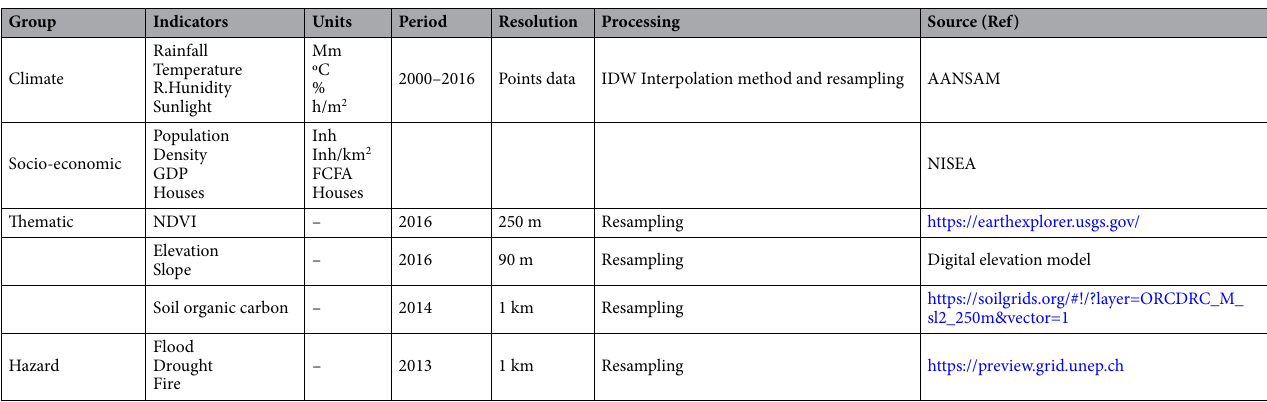
gross domestic product (GDP), and number of houses; thematic data such as the normalized difference vegeta- tion index (NDVI), soil organic carbon, digital elevation model (DEM) and slope; and environmental hazard data 3,34 such as flood, drought and bush fire frequency. Climate data were obtained from the Agency for Aerial Navigation Safety in Africa and Madagascar (AANSAM), socioeconomic data were provided by the National Institute for Statistics and Economic Analysis (NISEA), and hazard data were obtained from the United Nations